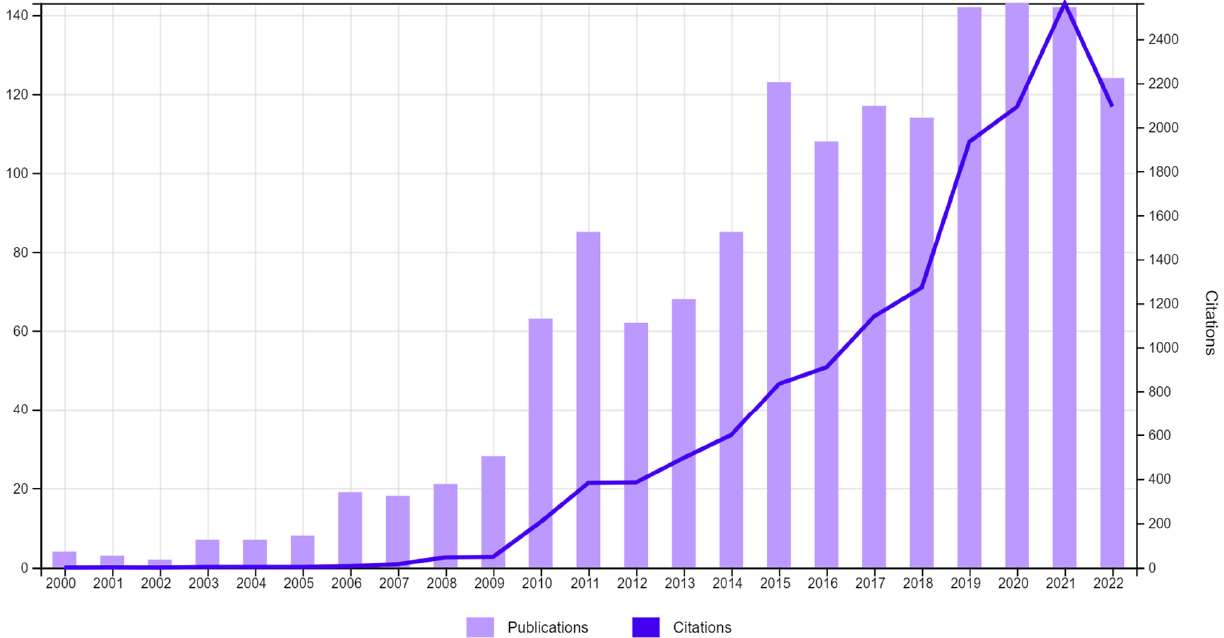
Table 2. Top ten research areas related to health tourism. Field of Research